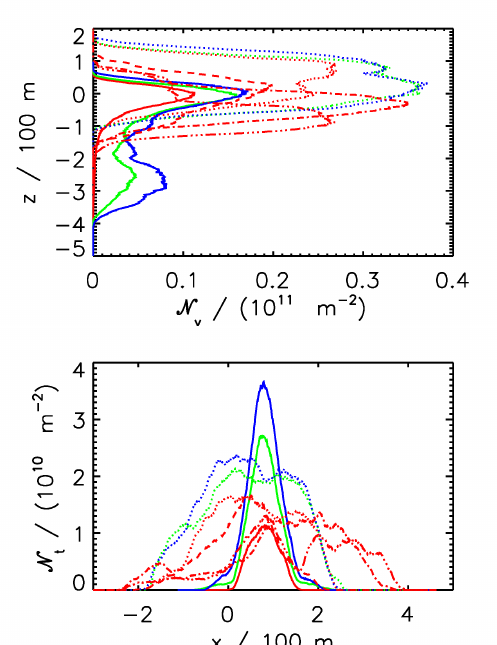
Figure 2. Contrail vertical and transverse ice crystal number profiles at initialisation for reference scenarios with a single aircraft (REF, solid) and formation flight scenarios with two aircraft (FF, all other line-styles). The initialisation data are taken from 3D vortex phase simulations, for REF from Unterstrasser [33] and for FF from Unterstrasser and Stephan [23]. Profiles are displayed for different initial ambient RH i,0 ∗ ( 110%,120% or 140%: red, green, blue). For RH i,0 ∗ = 110%, four different FF cases are shown (all red non-solid lines). The four cases are taken from a sensitivity study where the lateral separation DX of the two aircraft in formation was slightly varied ( DX = 45,50,55 or 60m). The flight altitude is at z = 0 and the single aircraft is centred around x = 80m.